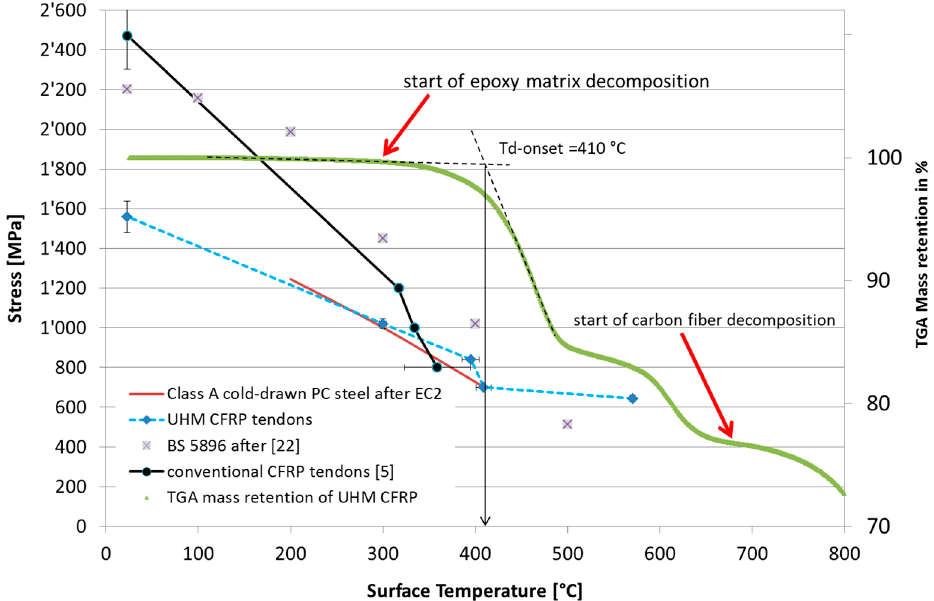
Figure 10. High-temperature tensile strength test results for novel UHM CFRP reinforcing tendons, compared against conventional CFRP tendons [6], BS 5896 steel prestressing wires [24], and guidance from Eurocode 1992-1-2 [25]; also including TGA mass loss curve for the novel UHM CFRP.